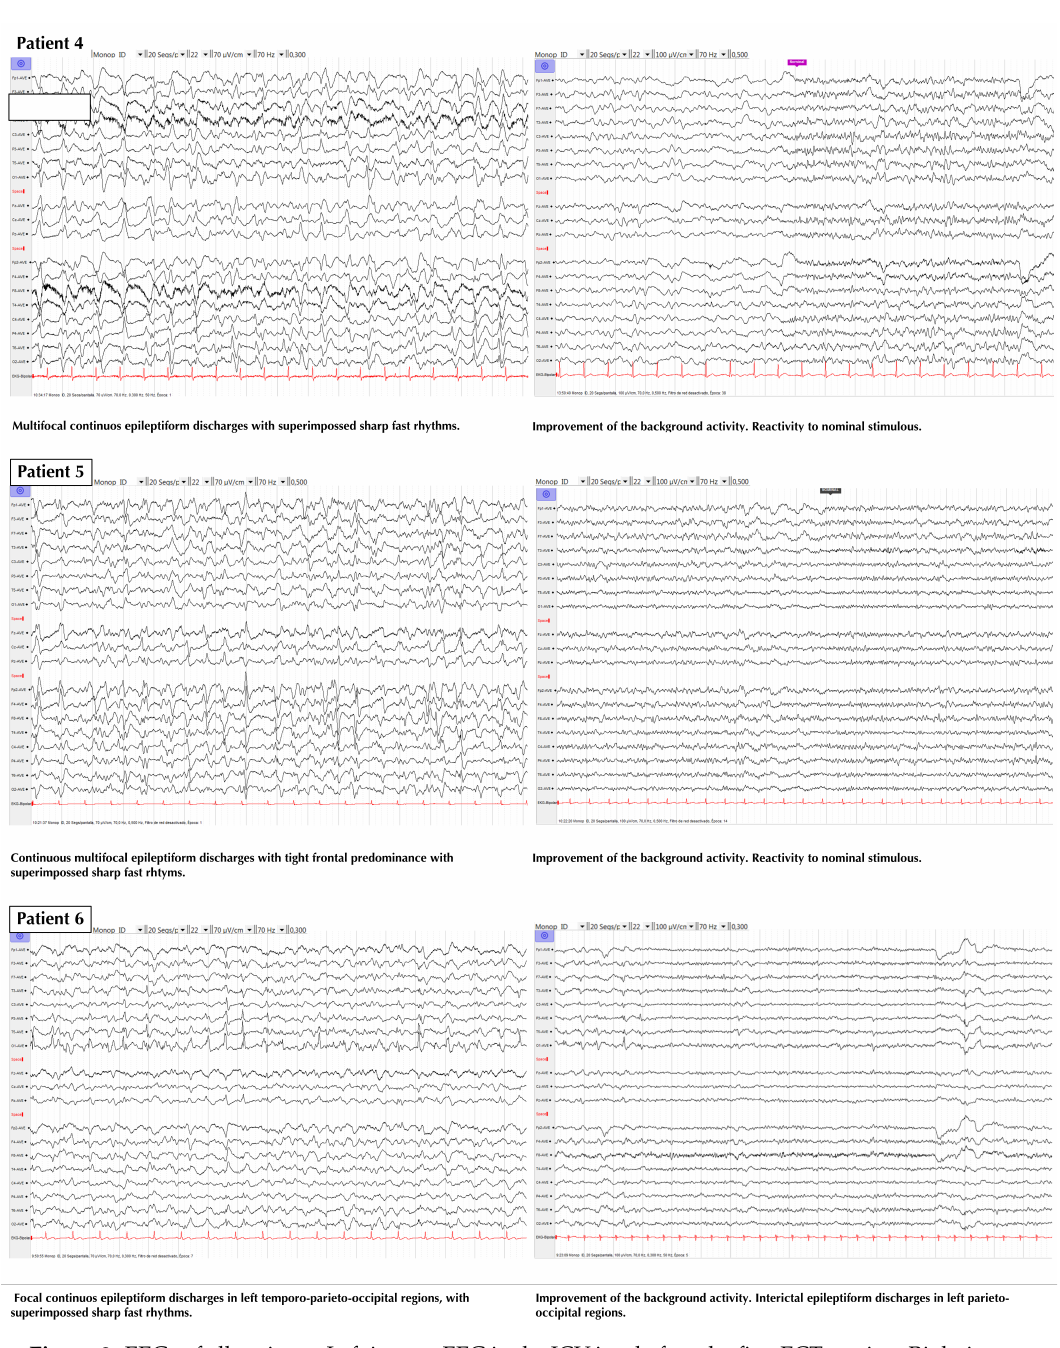
Figure 2. EEGs of all patients. Left image: EEG in the ICU just before the first ECT session; Right image: EEG the day after the last ECT